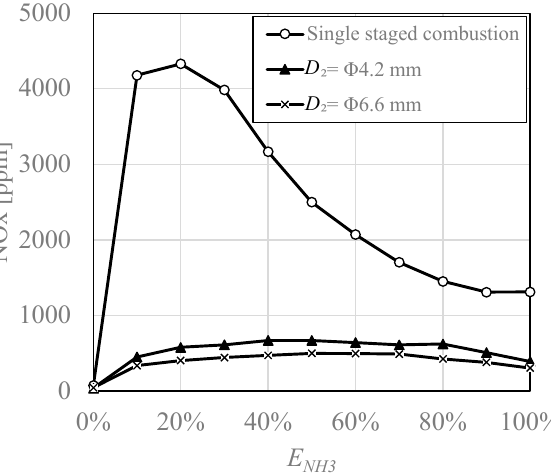
Figure 5. Comparison of NOx emissions rates for single-stage and two-stage combustion. Input = 11.63 kW, λ total = 1.2, L = 100 mm.